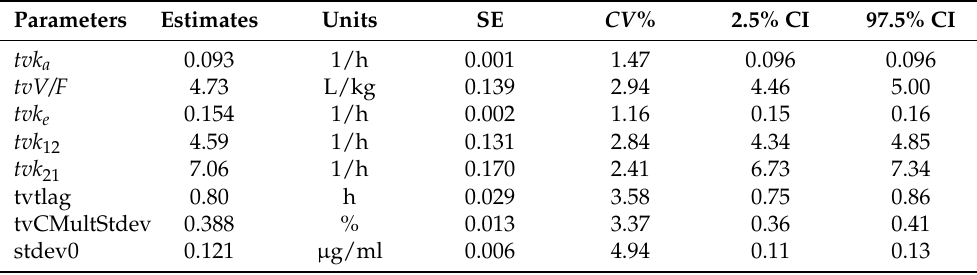
Table 1. Population parameters of orally administered doxycycline via drinking water at the dose rate of 20 mg/kg b.w./24 h for 5 days, alone or with co-administration of N-acetylcysteine via feed at a dose rate of 100 mg/kg b.w./24 h for 5 days, in healthy and in M. gallisepticum -infected broiler chickens (n = 32).